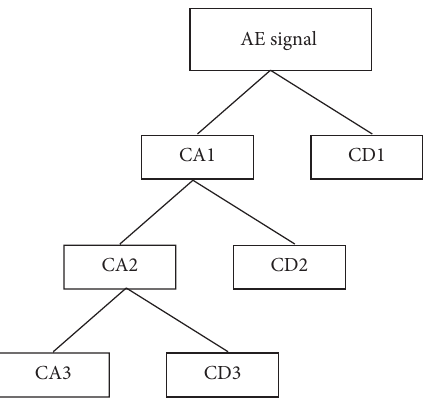
Figure 3: Topology structure of wavelet decomposition with 6